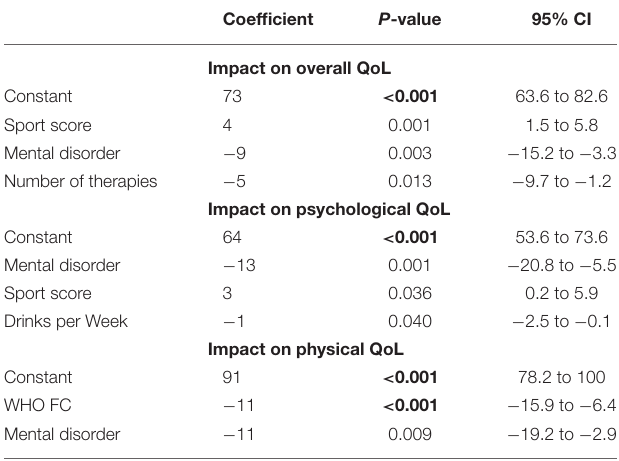
FIGURE 2 | Receiver operating characteristic (ROC) curves of the Hospital Anxiety and Depression Scale (HADS) for the detection of panic disorder (A) and depression (B) . TABLE 3 | Results of the linear regression analysis for determinants of quality of